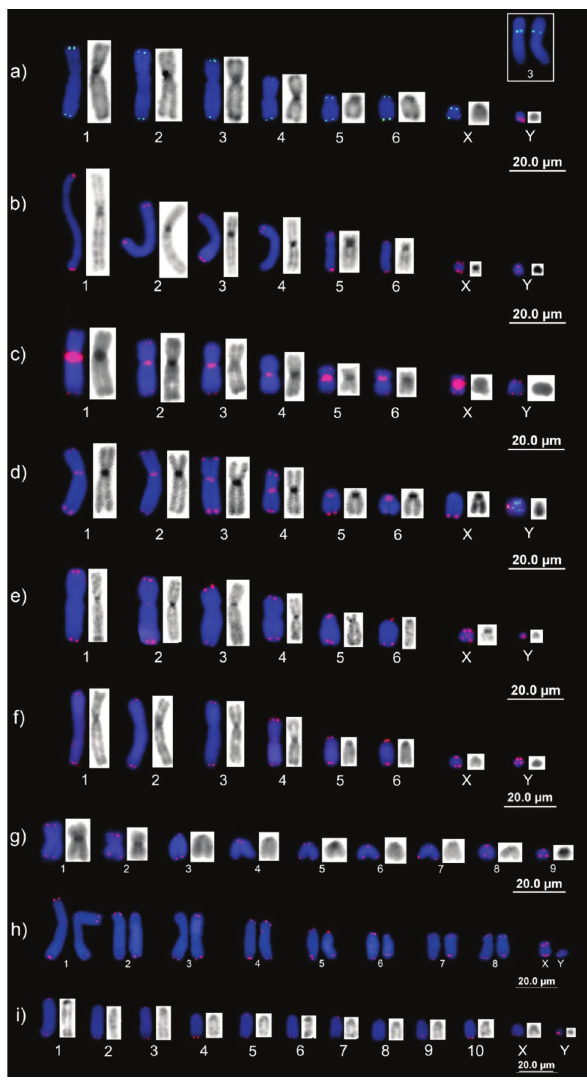
Figure 2 - Chromosomes after the hybridization of the telomeric se- quences (left) and after C-banding (right) of: a) Composite karyotype of Caluromys philander (Supplementary Material 1); b) Gracilinanus cf. peruanus ; c) Marmosops pinheiroi ; d) Marmosa demerarae ; e) Marmosa murina ;f) Metachirusnudicaudatus ;g) Glironiavenusta ;h) Monodelphis sp. nov.; i) Didelphis marsupialis. The acronyms refer to INPA’s collec- tion number and/or field number of the specimens shown in each